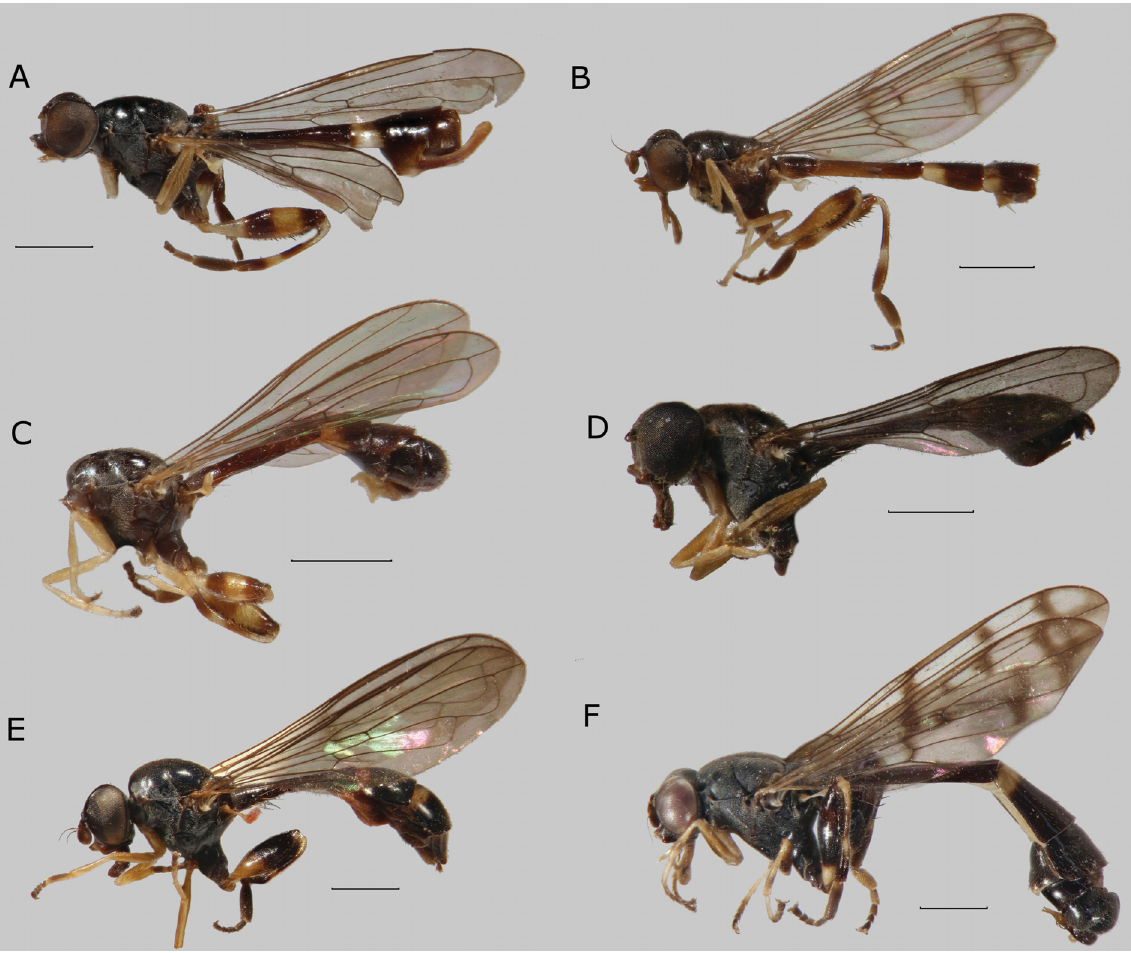
Fig. 82. Habitus, lateral view. A . Sphegina (Asiosphegina) siculifera Hippa, van Steenis & Mutin, 2015, paratype, ♂ , Myanmar. B . S. (A.) simplex Hippa, van Steenis & Mutin, 2015, paratype, ♂ , Myanmar. C . S. (A.) sinesmila Hippa, van Steenis & Mutin, 2015, paratype, ♂ , Myanmar. D . S. (A.) spathigera sp. nov., holotype, ♂ , Philippines. E . S. (A.) cf. spathigera sp. nov., ♀ , Philippines. F . S. ( A.) strigillata sp. nov., paratype, ♂ , Vietnam. Scale bars = 1.0